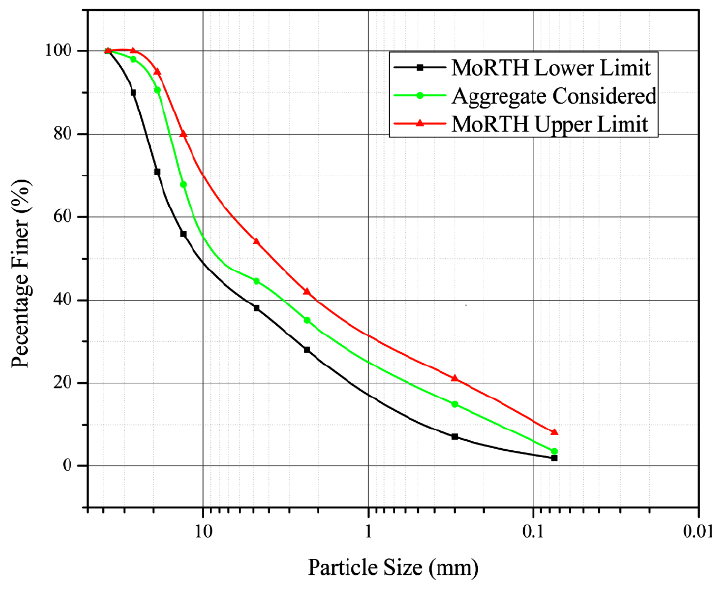
Figure 1. Aggregate grading curve with MoRTH upper and lower limits.